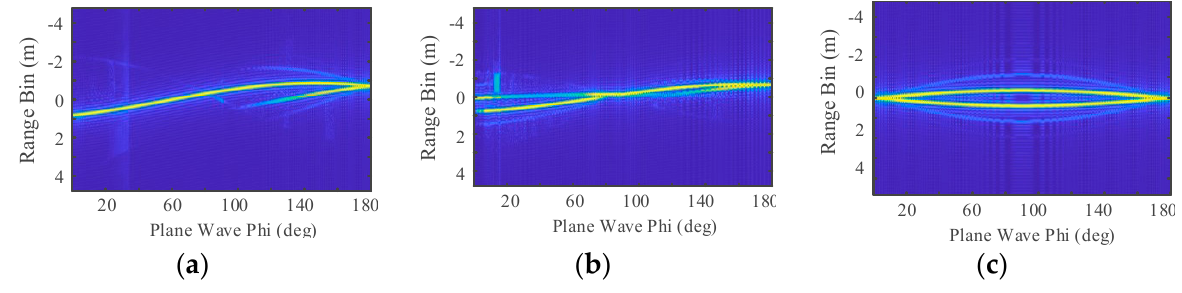
(cid:2) (cid:3) 0 ◦ ,180 ◦ : ( a ) HRRPs of cone; ( b ) HRRPs of